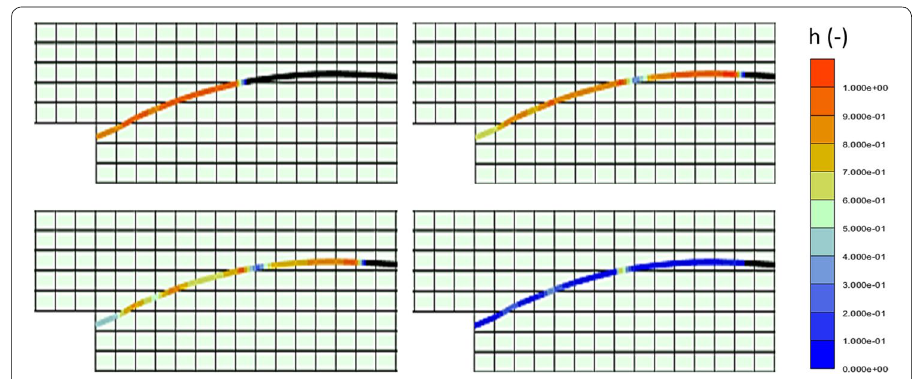
Fig. 15 Contour plots of degree of healing at a (top left), b (top right), c (bottom left) and d (bottom